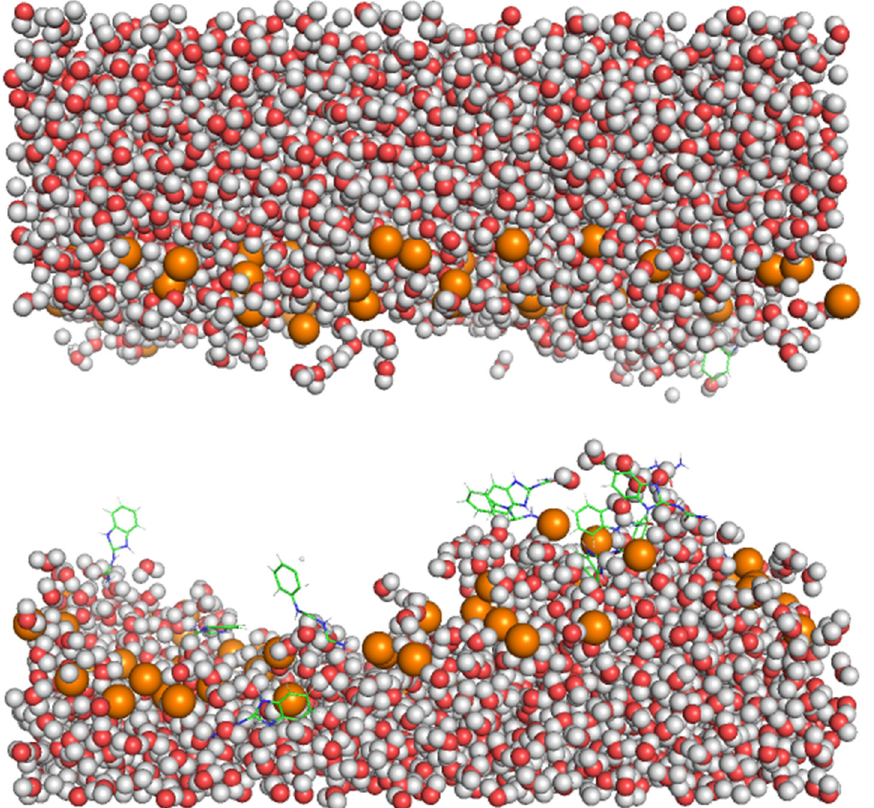
Figure 8. Pore formation. BZIMU molecules form a cluster that is surrounded by water molecules.